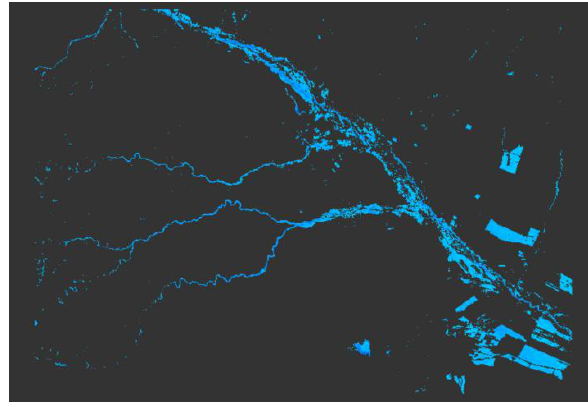
Figure 10. Flooded area according to